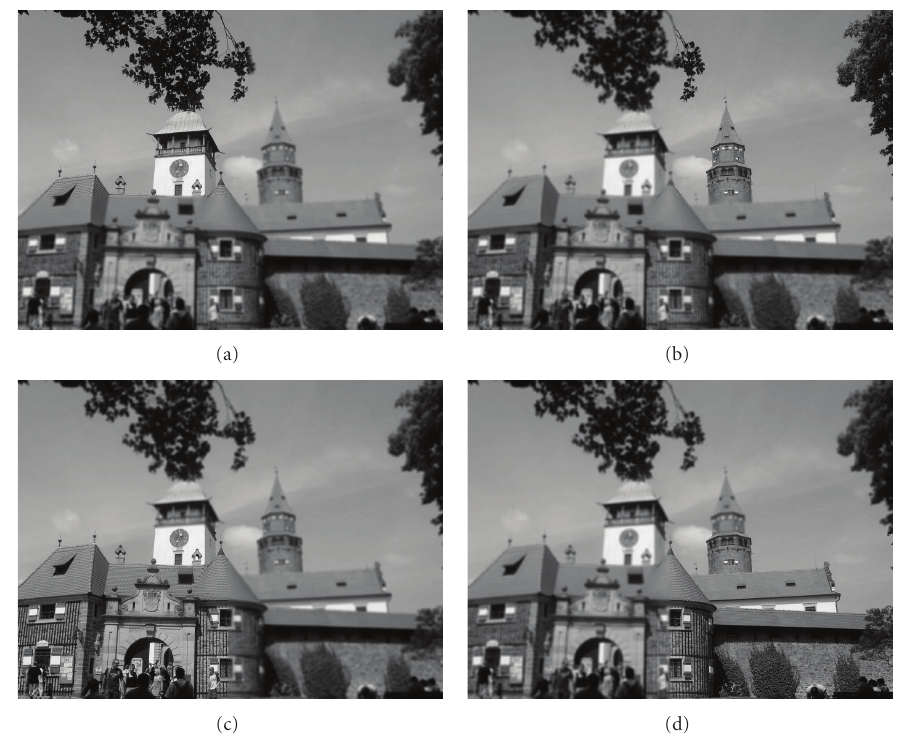
Figure 3: Four inputs (sharp zones vary from the northwest to the southeast quatre) of the image “Castle.”